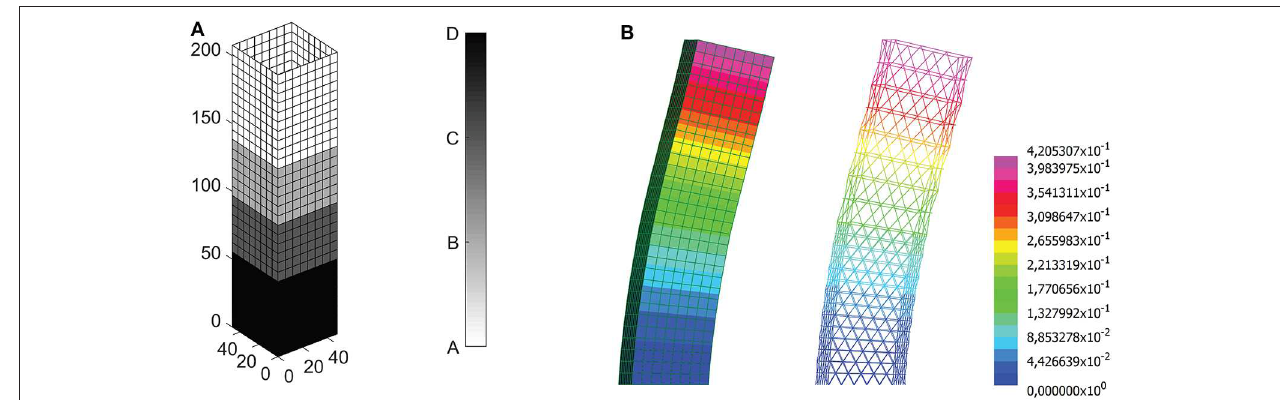
FIGURE 10 | A diagrid with varying cross-sections and varying reference dimensions for a tall building with square plan: (A) optimal solution, W magnified deformed shapes computed through the multiscale approach and a beam model (displacements in m).